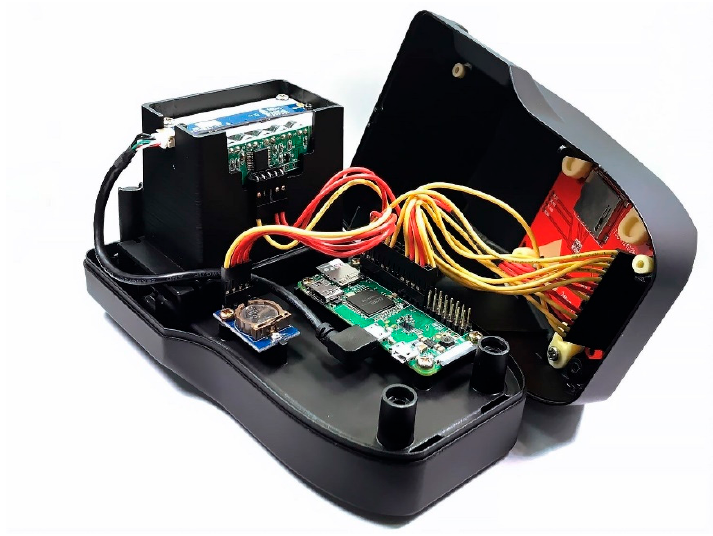
Figure 2. The immunodetection system.